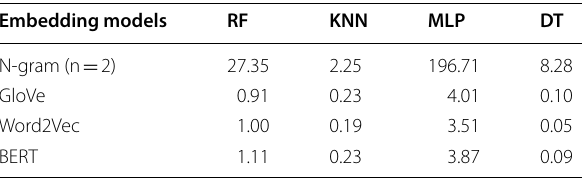
Table 10 The time in training embedding models (s) Table 11 Training time of 16 combination of 4 embedding models and 4 classifiers (s)